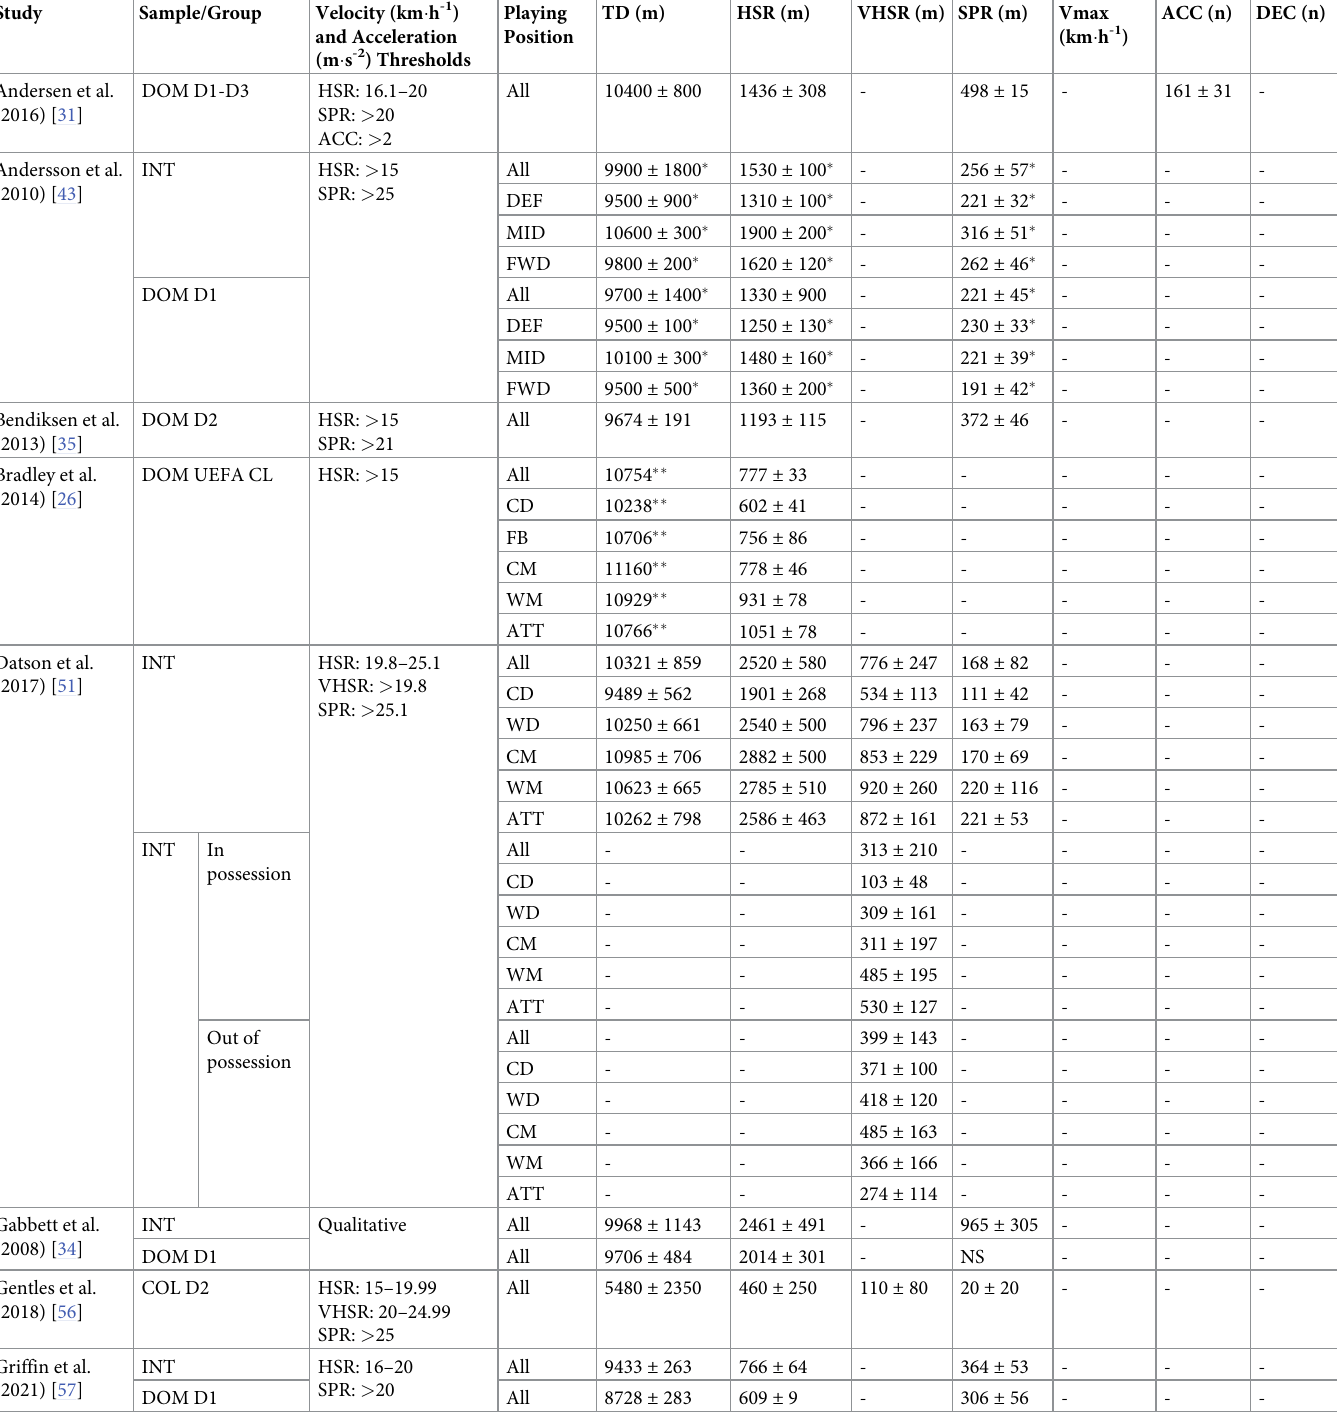
Table 6. Studies quantifying physical characteristics of women’s soccer match-play per whole-match as absolute data.